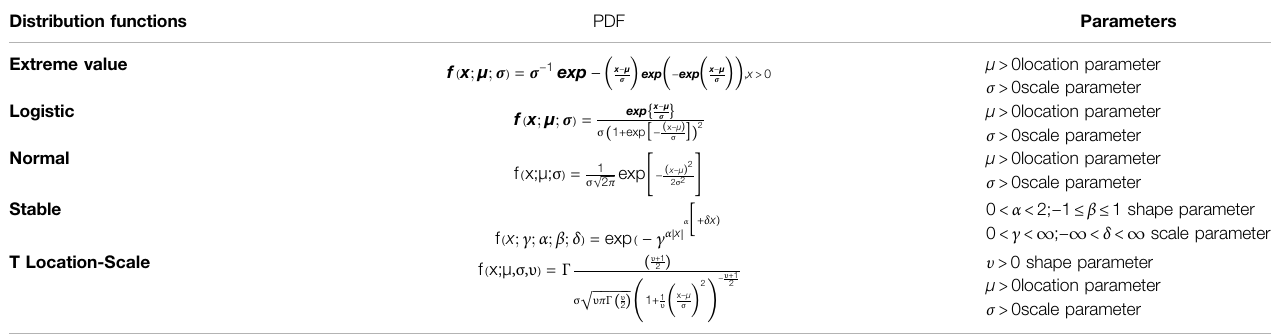
TABLE 1 | Probability distribution function (PDF) of the fi ve distribution functions used in the study.